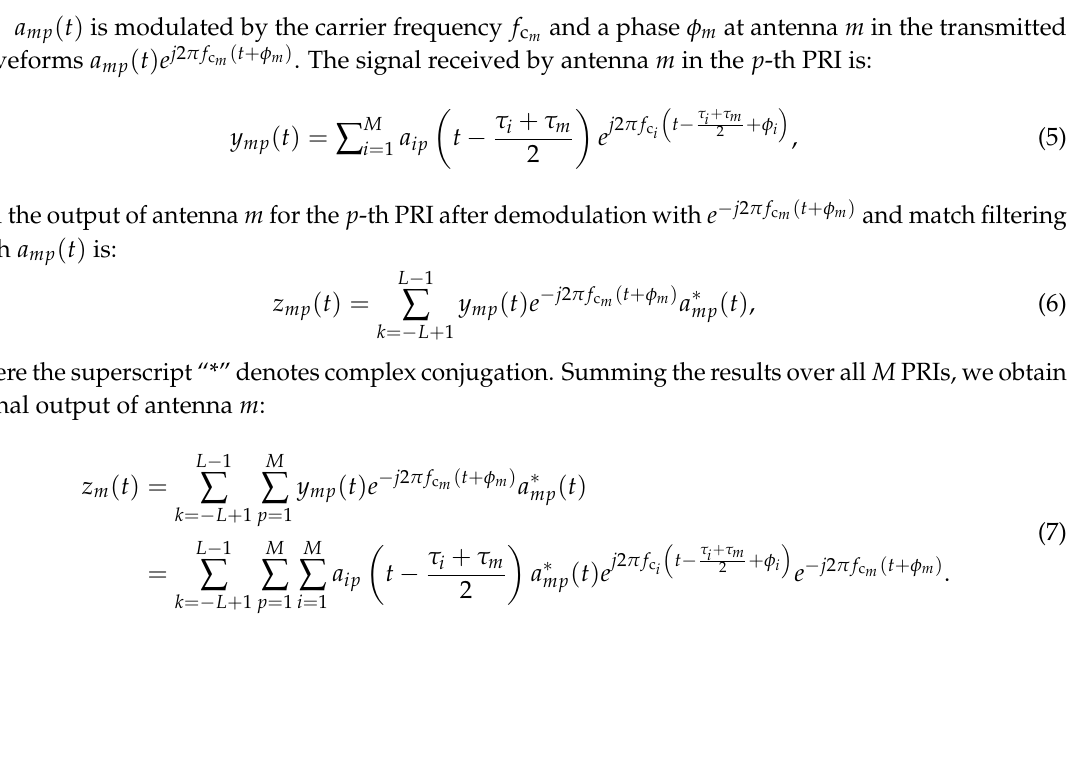
Figure 1. The schematic figure of the radar detection